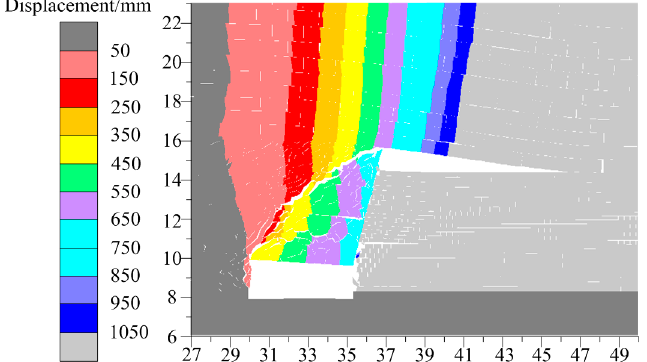
Figure 6. Simulated displacement map in the entry-surrounding rock.